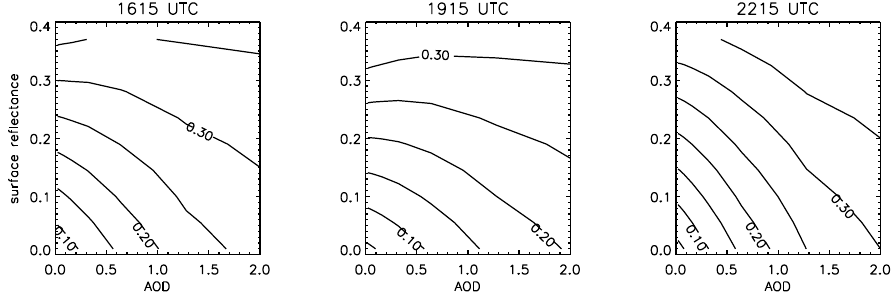
Fig. 4. Contour of TOA reflectance vs surface reflectance and AOD at Railroad Valley